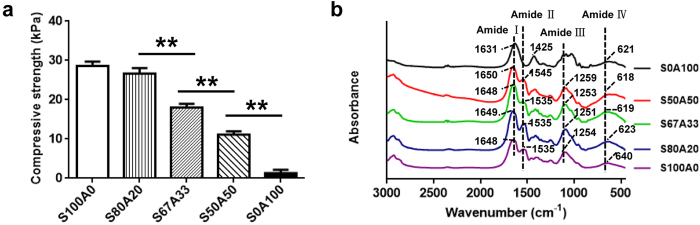
The mechanical strength and the FTIR spectra of the IPN hydrogels.(a) Quantification of compressive moduli of the pure sericin (S100A0), the three sericin/alginate IPN hydrogels (S80A20, S67A33, and S50A50), and the pure alginate hydrogel (S0A100) (n = 3 per group; ANOVA test; **P < 0.01). (b) FTIR spectra show the absorption peaks of amide I, II, III and IV (indicated) of the pure sericin (S100A0, purple line), the three sericin/alginate IPN hydrogels (S80A20, blue line; S67A33, green line; and S50A50, red line), and the pure alginate hydrogel (S0A100, black line).